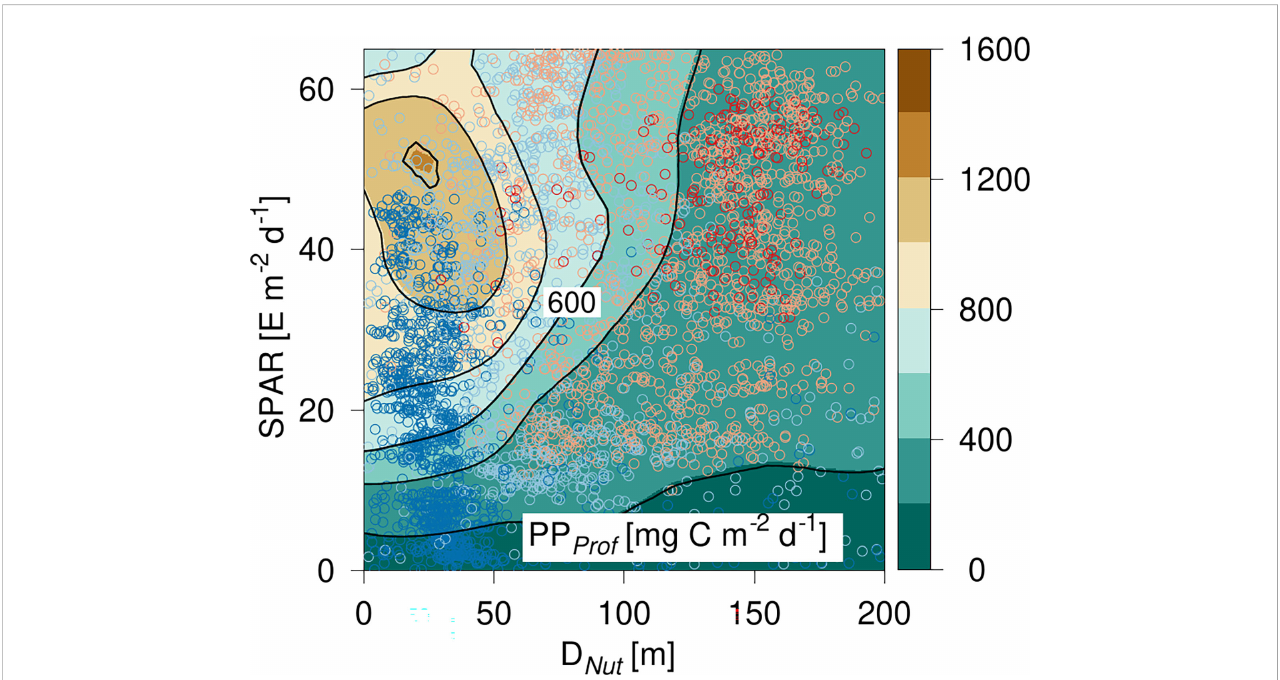
FIGURE 5 PP-diagram of primary production (PP) calculated from PP Prof based on Argo-pro fi les. PP is shown versus the corresponding nutricline depth (D Nut ) calculated from Argo-pro fi les and daily averaged Photosynthetic Available Radiation at the surface (SPAR) obtained from satellite observations. Color shading of the circles shows the location of the corresponding pro fi le (see Figure 2).